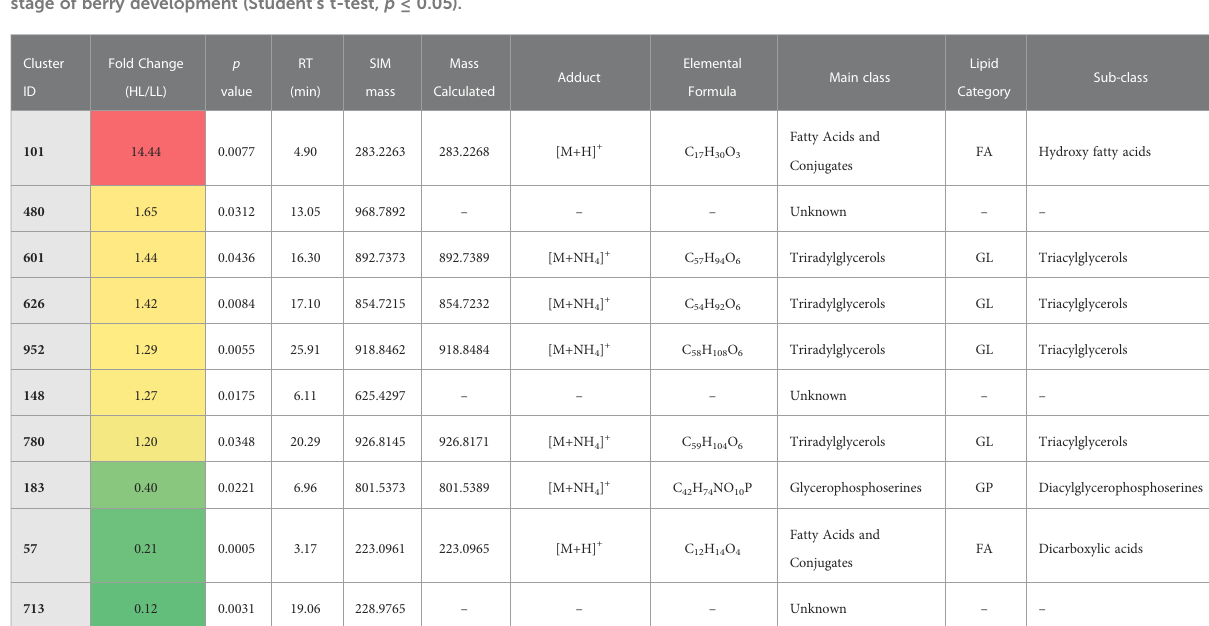
Metabolites are ordered by their fold change values (ratio HL/LL grapes) and the red-green patterns indicate the differences between the two light microclimates. For more details see Supplementary Table 1. Cluster ID – metabolite number. RT – chromatographic retention time. SIM mass – mz of putative molecular ion (highest signal in mass cluster). Lipid categories: FA, Fatty Acyls; GL, Glycerolipids; GP,